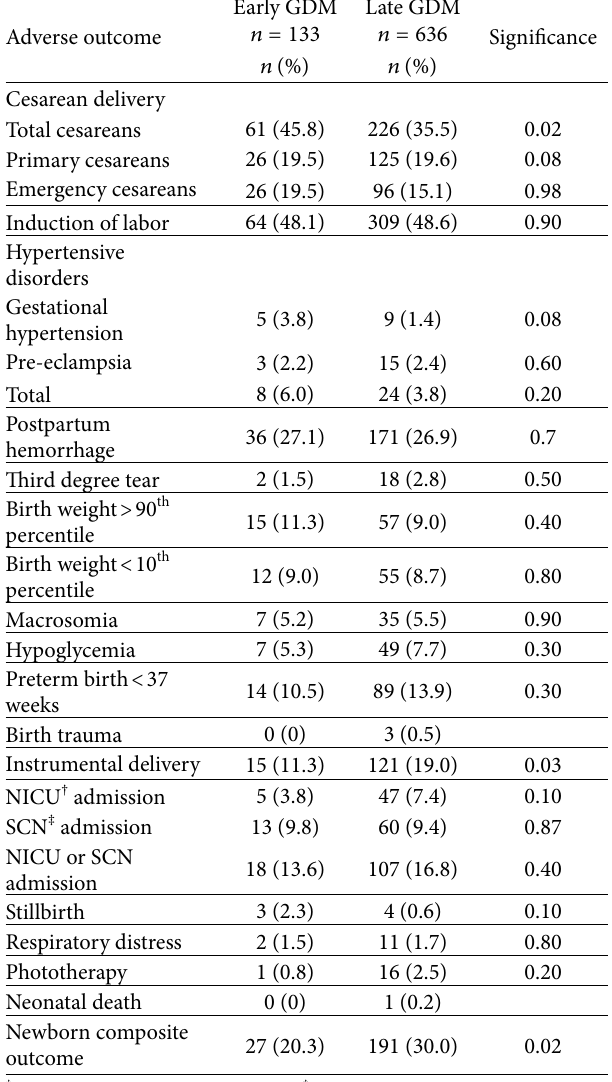
Table 2: Adverse pregnancy outcomes in early GDM and late GDM. Early GDM had a significant decrease in frequency of newborn composite outcome compared to Late GDM. Composite includes one or more of hypoglycemia, birth trauma, NICU/SCN admission, stillbirth, neonatal death, phototherapy and respiratory